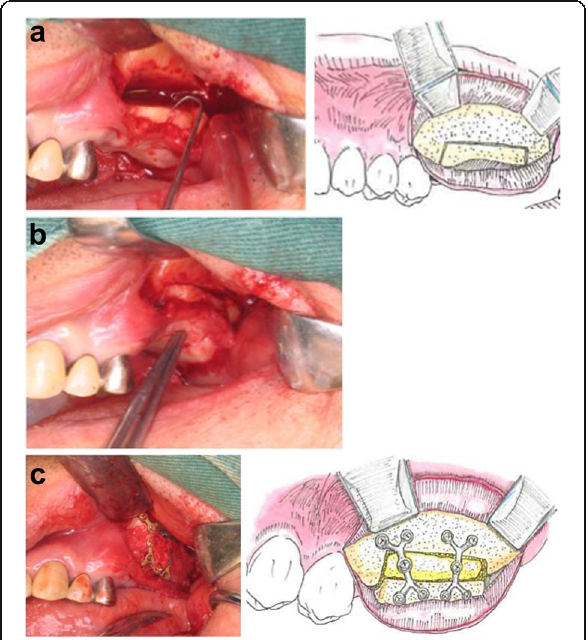
Fig. 3 a A paracrestal incision was made on the buccal side, and horizontal and vertical osteotomies were made with a piezo-electric device. b Placement of the ramus bone block as an